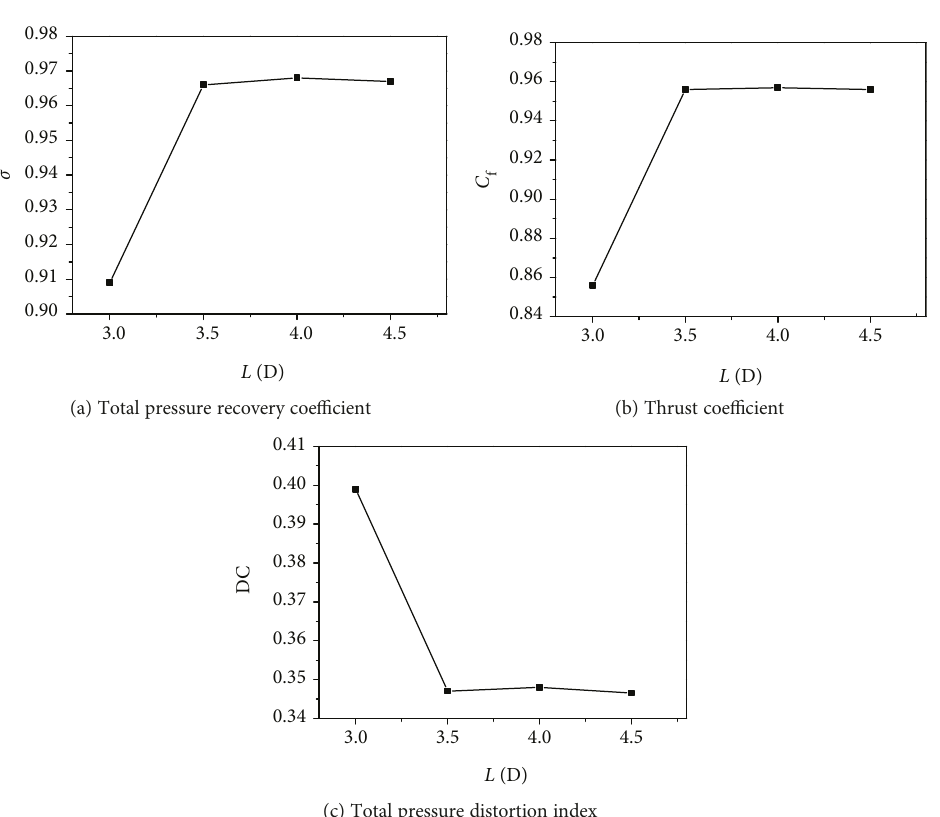
Figure 15: Comparison of performances of nozzles with di ff erent L / D ( W / H = 3 3 , S / D = 0